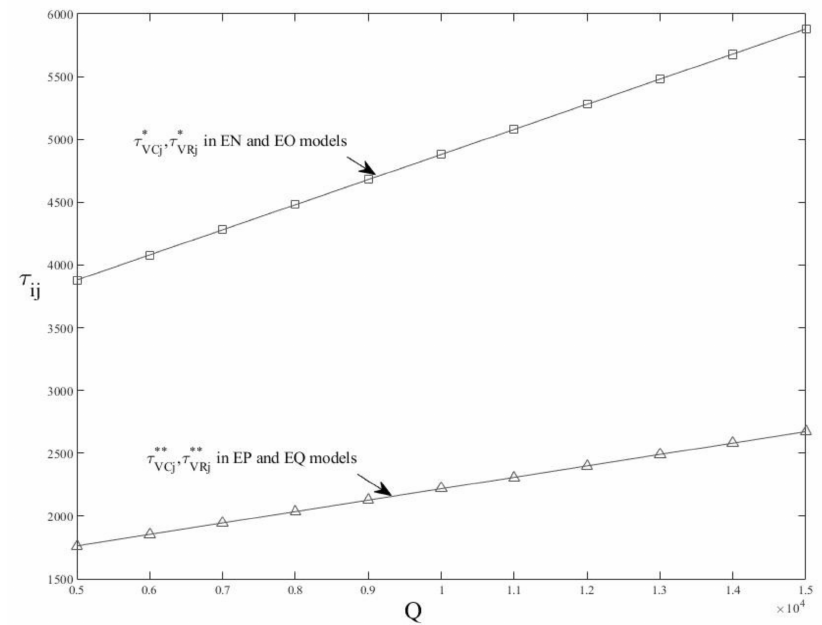
Figure 2. The impact of Q on τ ij .